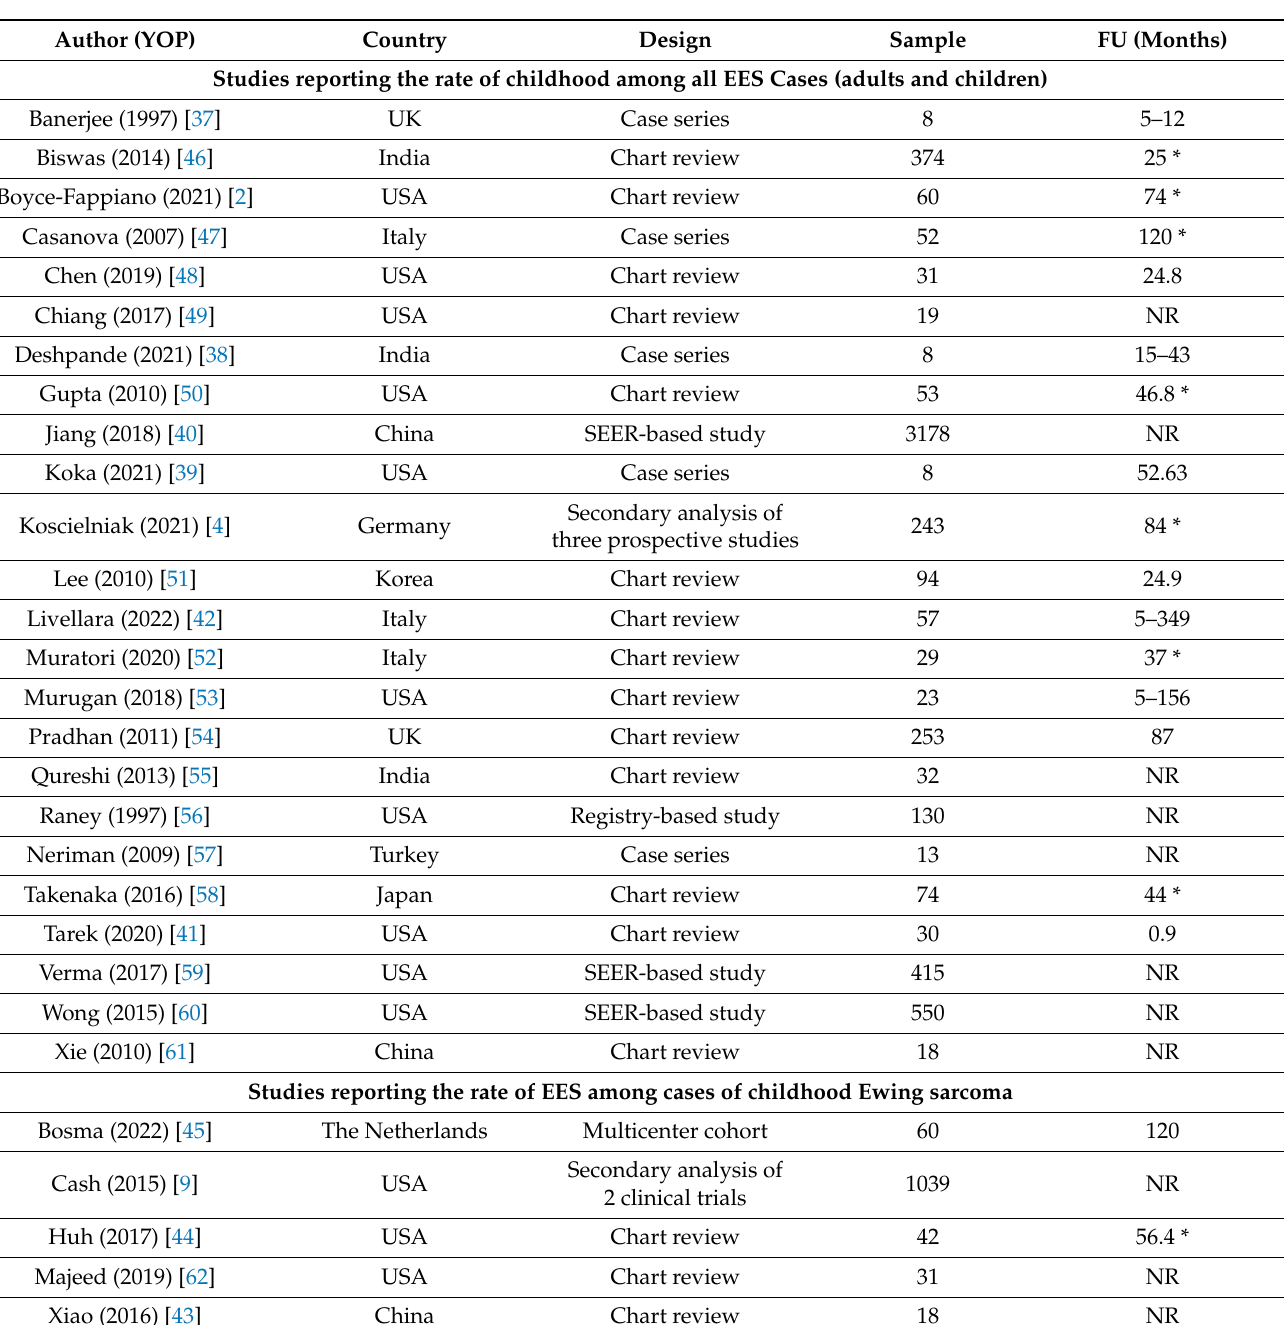
Table 1. Baseline characteristics of the included